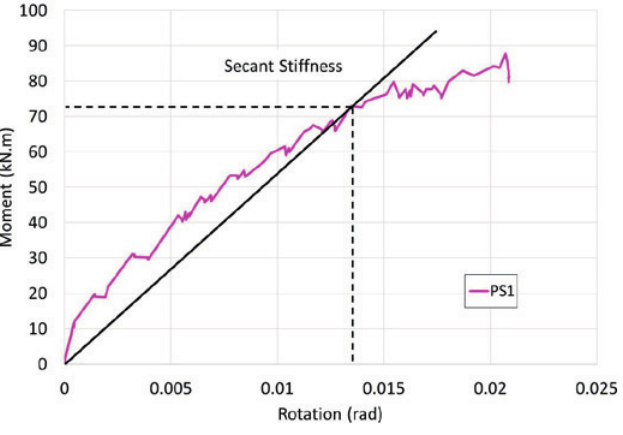
Figure 23 – Moment-rotation curve: specimens PC1 and PC2